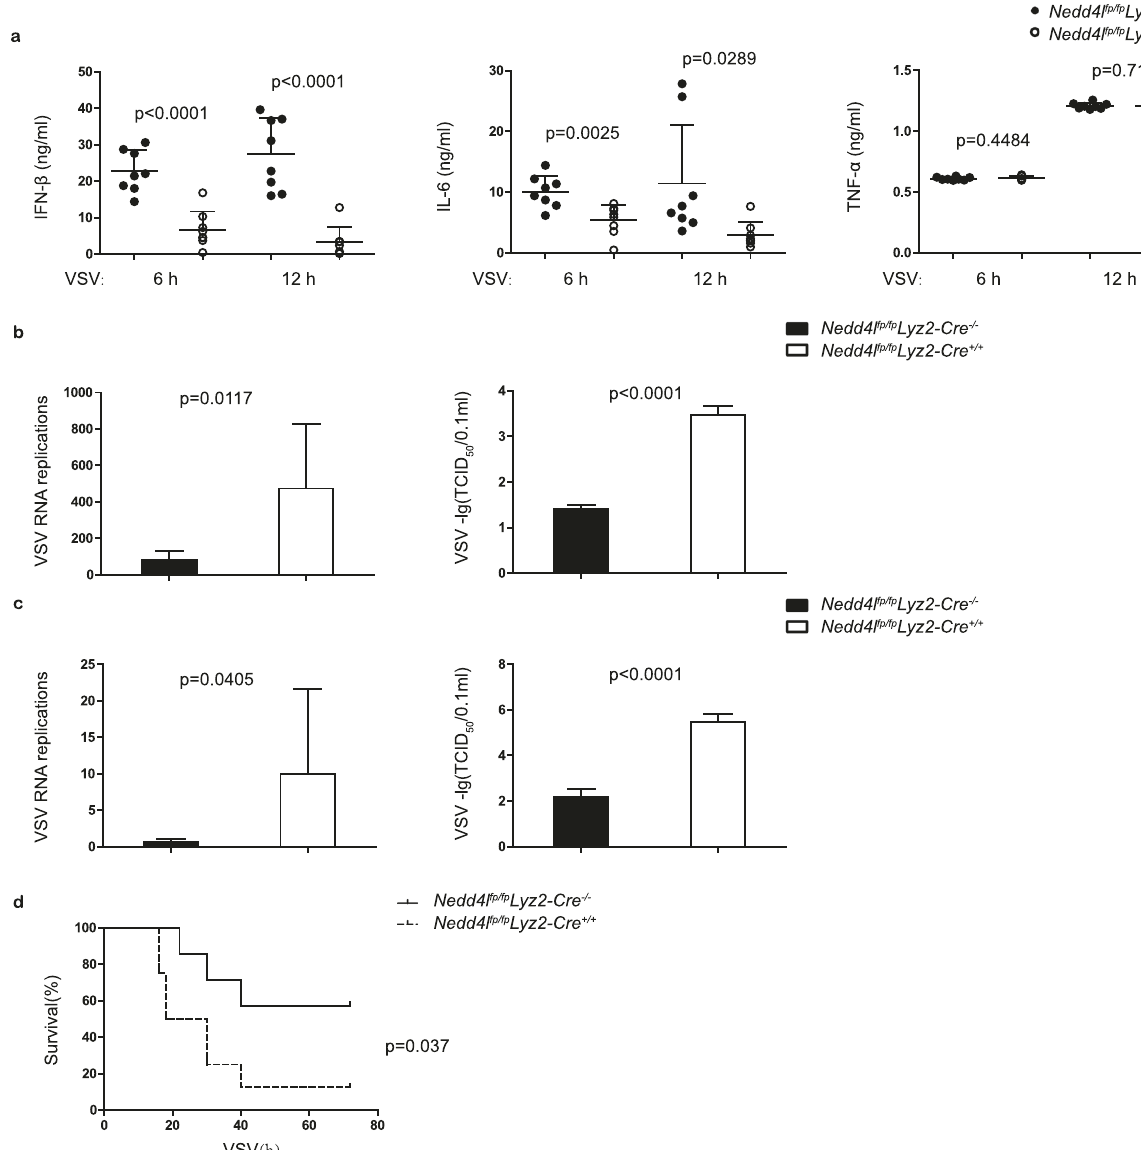
Fig. 2 Conditional Nedd4l de fi ciency inhibited antiviral innate immunity in vivo. a ELISA assay of IFN- β , IL-6, and TNF- α in serum of control Nedd4l fp/fp Lyz2-Cre − / − and Nedd4l fp/fp Lyz2-Cre + / + mice intraperitoneally infected with VSV (4 × 10 5 PFU/g) for 6 and 12 h ( n = 8 per group). b, c RT- qPCR analysis of VSV mRNA and TCID 50 in spleen ( b ) and liver ( c ) in control Nedd4l fp/fp Lyz2-Cre − / − and Nedd4l fp/fp Lyz2-Cre + / + mice intraperitoneally infected with VSV (4 × 10 5 PFU/g) for 24 h (RT-qPCR analysis n = 8 and TCID 50 n = 6). d The survival rates of control Nedd4l fp/fp Lyz2-Cre − / − and Nedd4l fp/fp Lyz2-Cre + / + mice were monitored for 3 days after intraperitoneally infected with VSV (8 × 10 5 PFU/g) ( Nedd4l fp/fp Lyz2-Cre − / − n = 7 and Nedd4l fp/fp Lyz2-Cre + / + n = 8, and p -values by two-tailed unpaired Student ’ s t -test are indicated). Data are presented as mean ± SD and p -values by two- tailed unpaired Student ’ s t -test are indicated in ( a – c ) and p -value by Gehan-Breslow-Wilcoxon test are indicated in ( d ). Results in ( a – d ) are representative of three independent interaction between Nedd4l and TRAF3. Mapping the domain that mediated the binding of Nedd4l to TRAF3, a series of truncated Nedd4l mutants were constructed (Supplementary Fig. 4). Deletion of the C2 or HECT domain in Nedd4l did not affect the interaction between Nedd4l and TRAF3, however, deletion of both C2 and WW domain in Nedd4l disrupted the association between Nedd4l and TRAF3, suggesting that Nedd4l bound TRAF3 through its WW domain (Fig. 4d).